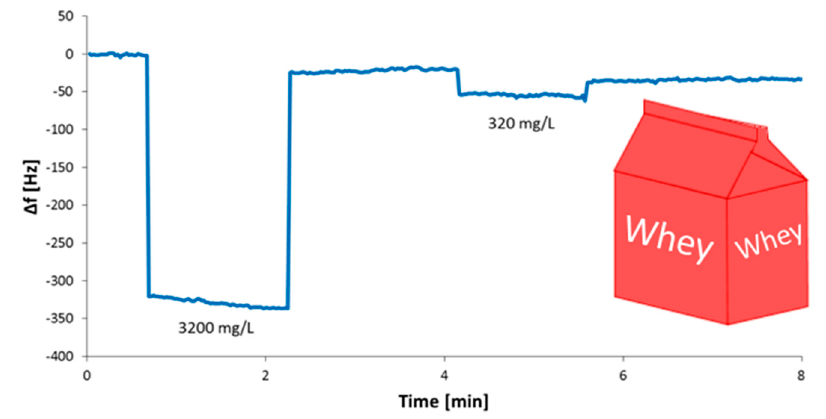
Figure 4. Sensor response for melamine measured in whey: ~ − 330 Hz at 3200 mg/L, ~ − 35 Hz at 320 mg/L.